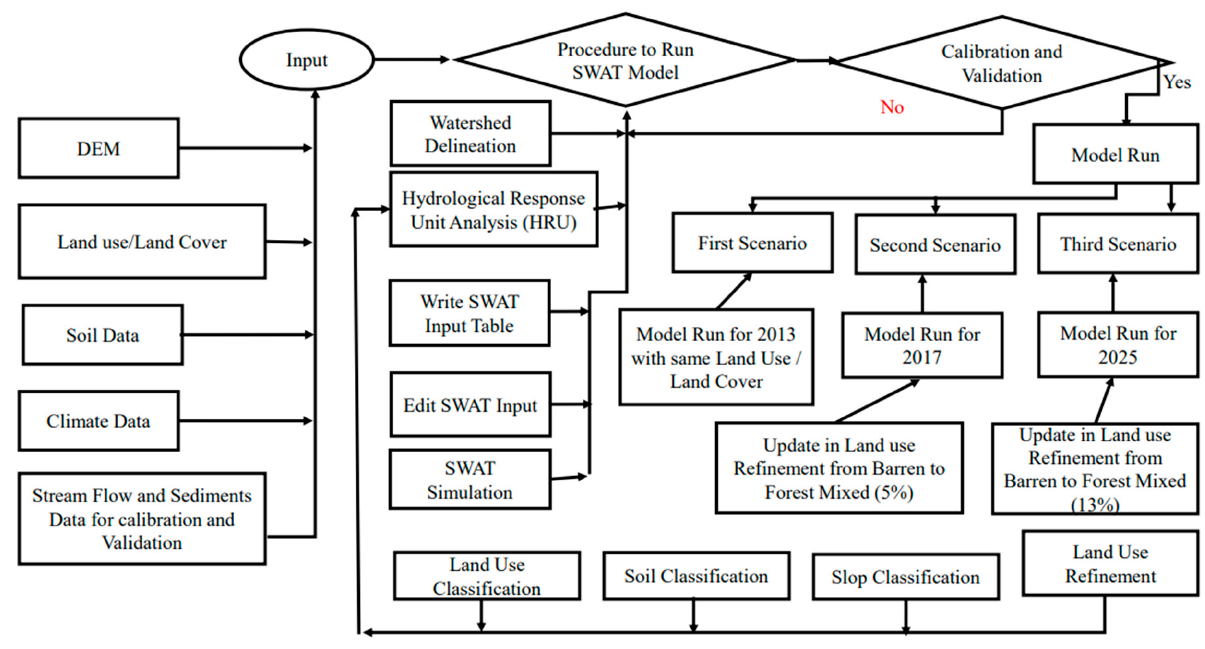
Figure 2. Workflow chart of the methodology.